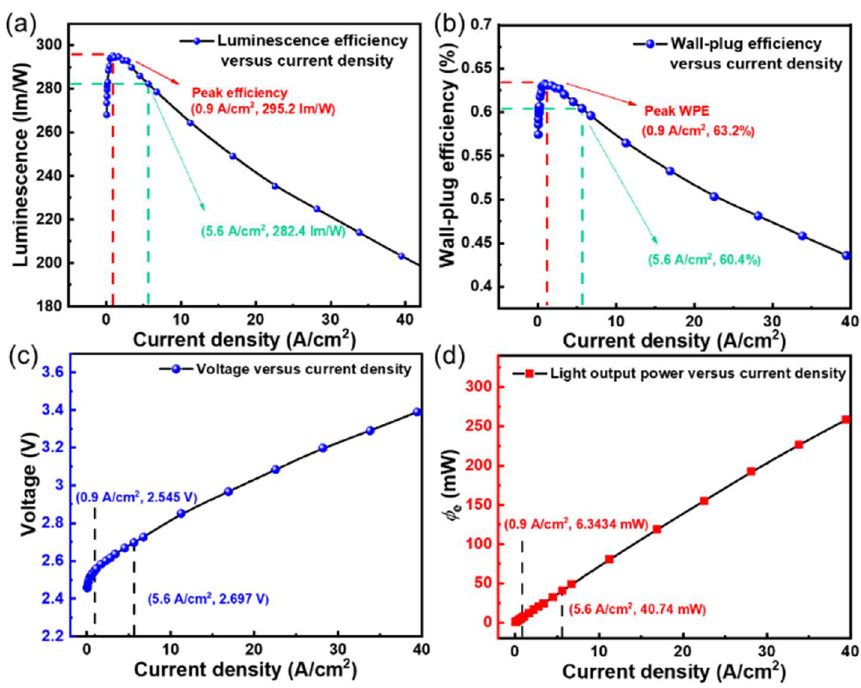
Figure 7. ( a ) η L as a function of J in for WLEDs; ( b ) WPE as functions of Jin for white LEDs; ( c ) J in and ( d ) φ e dependence of operating voltage for WLEDs.